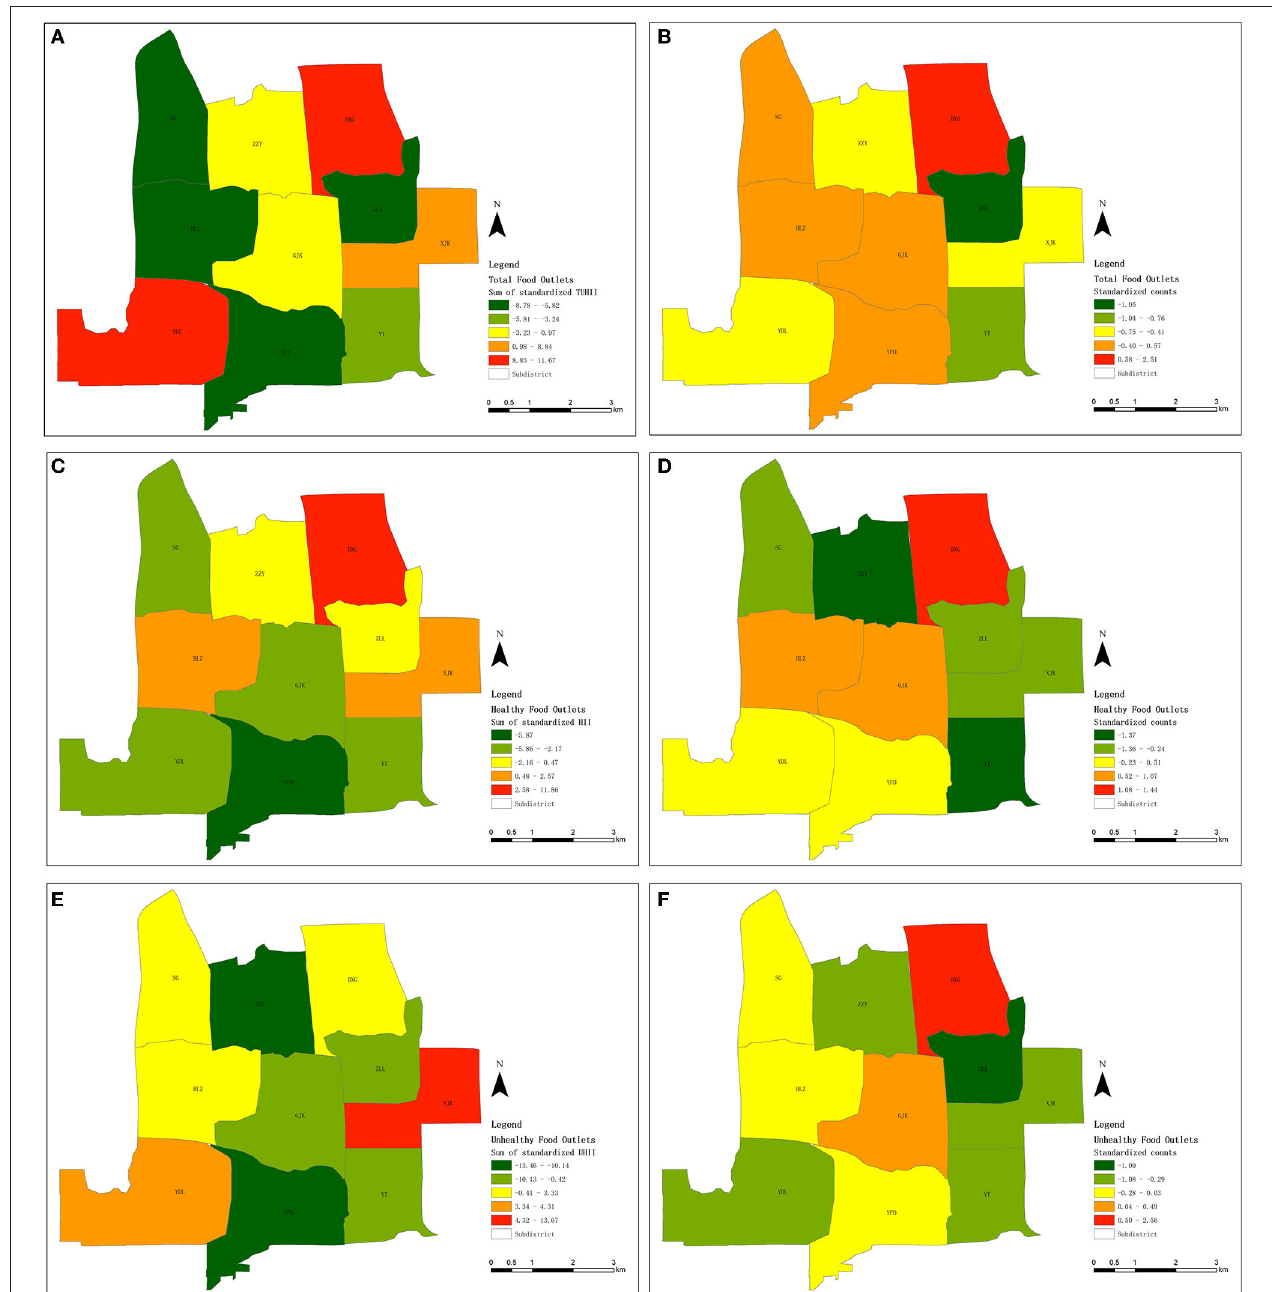
FIGURE 6 | Comparison between two measurements: (A, C, E) new method, and (B, D, F) old method (measuring the food environment by counting food outlets in an area). ND, Noodles and dumplings; WFF, Western fast-food; SET, Set meal; ST, Staple; HLR, Healthy and light recipes; UN, Unknown. BLZ, Balizhuang; BXG, Beixiaguan; GJK, Ganjiakou; SG, Shuguang; XJK, Xinjiekou; YFD, Yangfangdian; YDL, Yongdinglu; YT, Yuetan; ZLL, Zhanlanlu; ZZY, Zizhuyuan. (A) The standardized TUHII summed by subdistricts. (B) The standardized counts of total food outlets summed by subdistricts. (C) The standardized HII summed by subdistricts. (D) The standardized counts of healthy food outlets summed by subdistricts. (E) The standardized UHII summed by subdistricts. (F) The standardized counts of unhealthy food outlets summed by subdistricts.